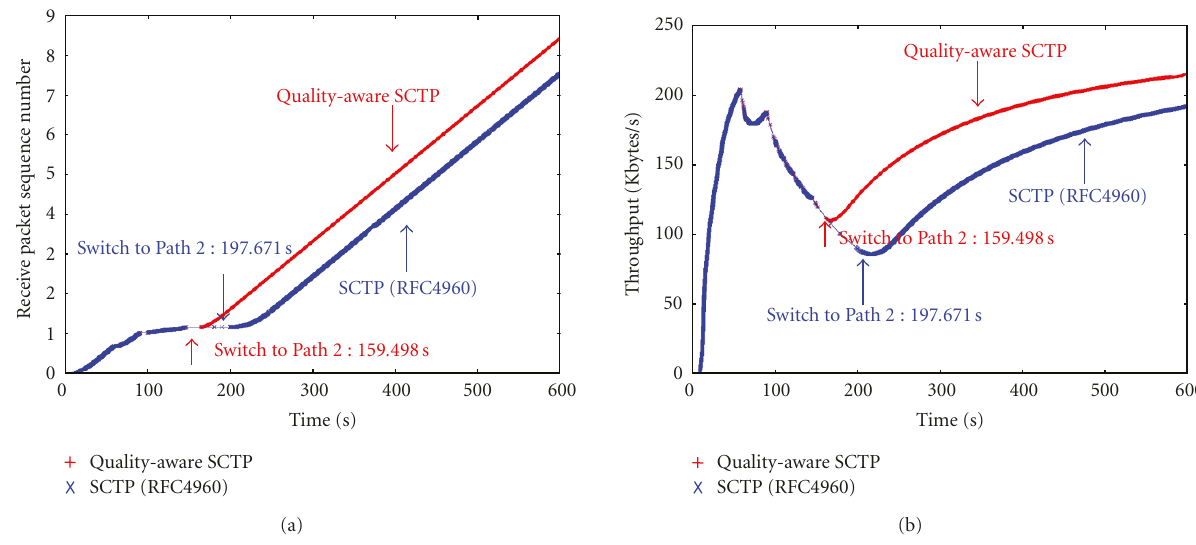
Figure 9: QA-SCTP Path failure detection mechanism experiment (with 30% bit error rate).